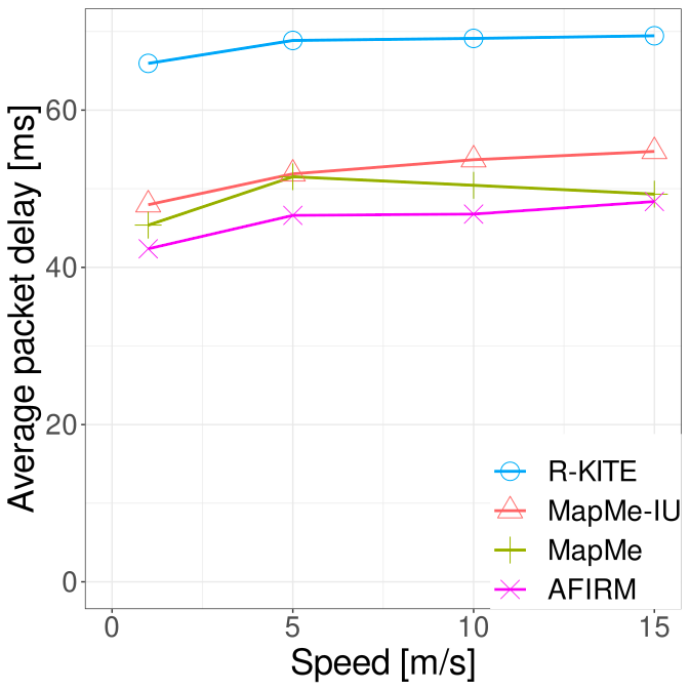
Figure 7. Data retrieval